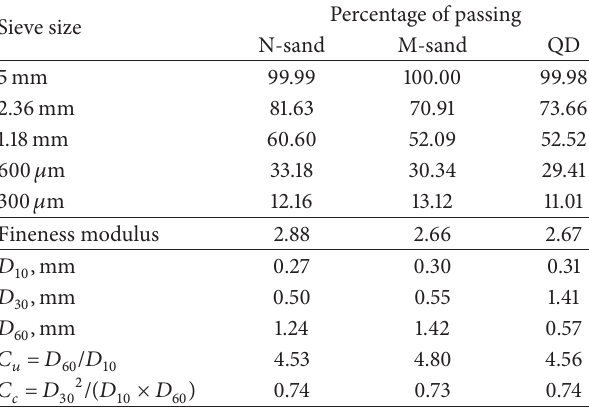
Table 2: Particle size distribution of N-sand, M-sand, and QD.